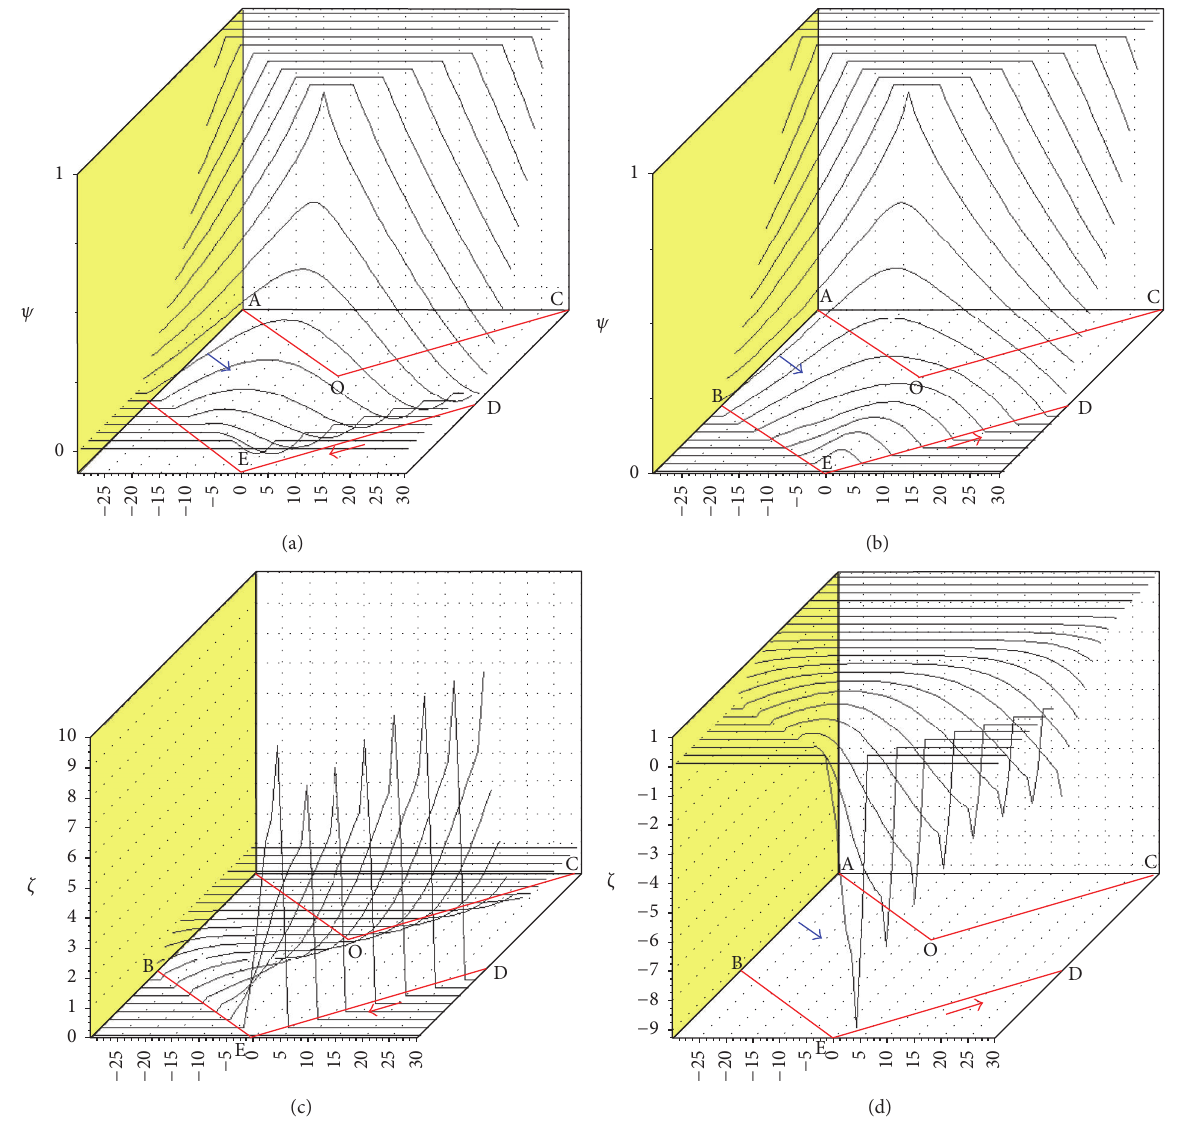
Figure 8: CFD-derived diagrams for the dimensionless flow function 𝜓 (a, b) and for the dimensionless curl function 𝜁 (c, d) for a Segal die with channel intersection angles ∠ (AOC) = 2 𝜃 = 105 ∘ , where outlet die wall ED moves upstream towards the punching direction with velocity = −𝑈 𝑉 𝑤 0 (a, c), outlet die wall ED moves downstream streamwise with velocity transition times are 1172 ms = 1.172 s (a, c) and 1831ms = 1.831 s (b,